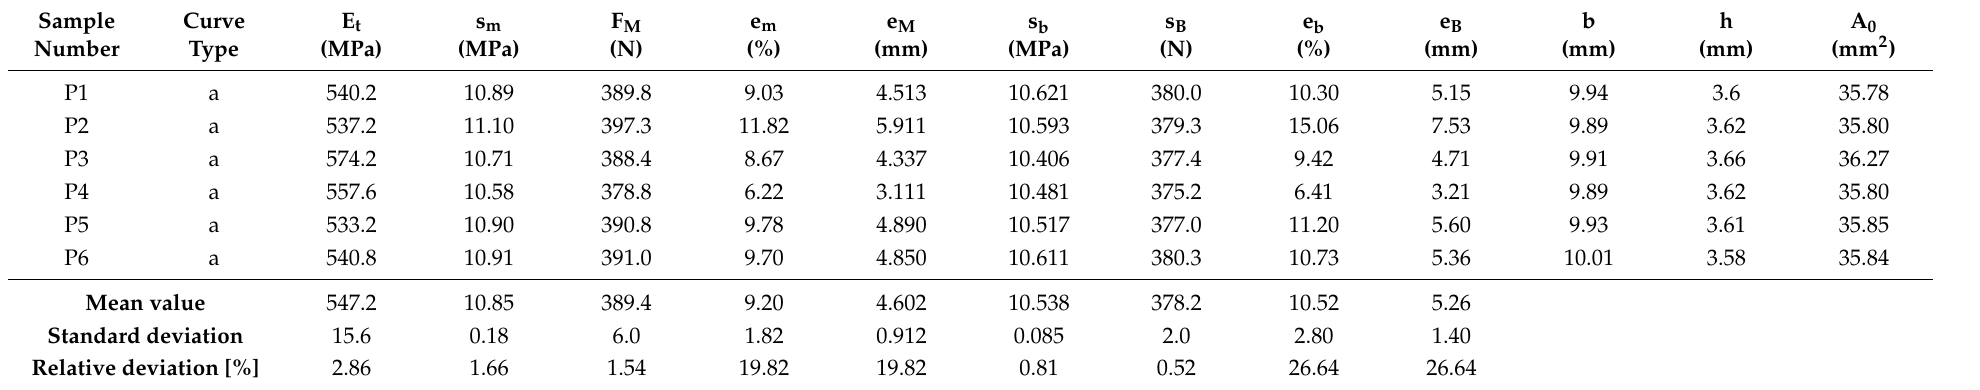
Table A28. Results of the tensile tests of P_C,PE.